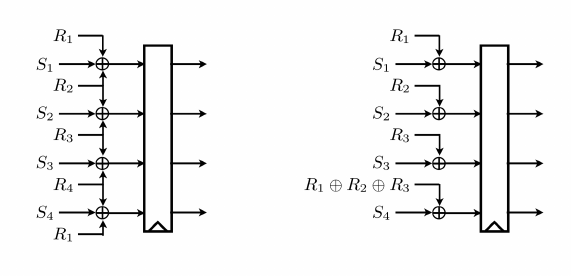
Figure 8: Ring and Additive Refreshing [CRB +